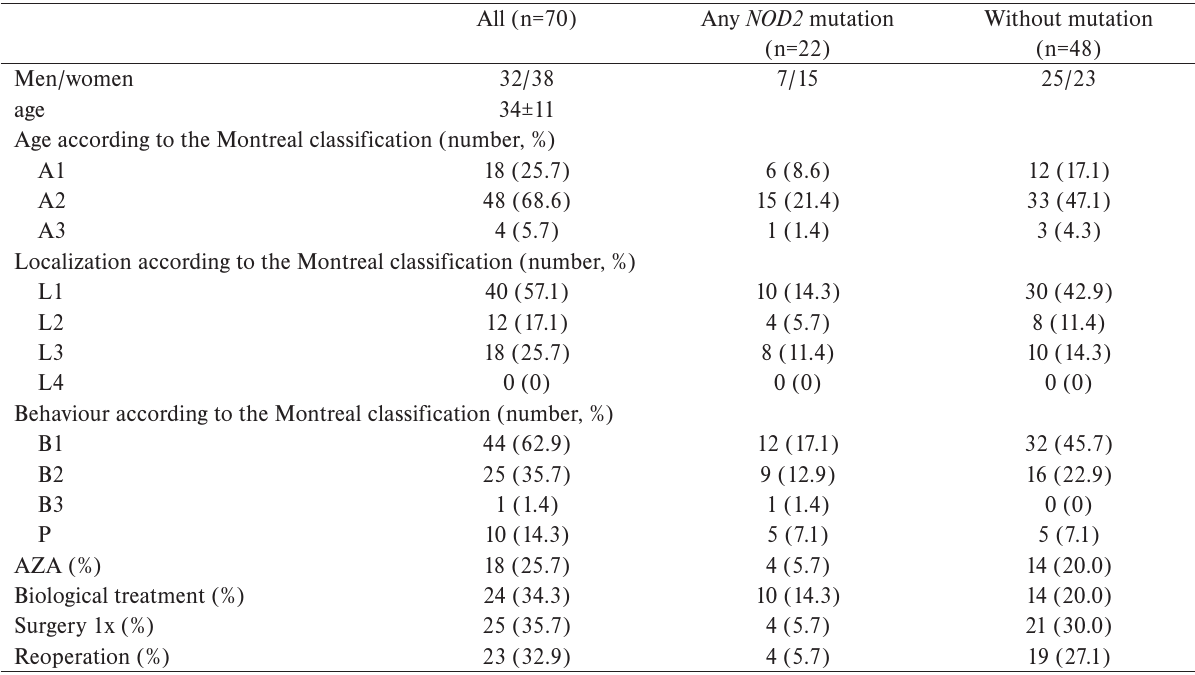
Table 1. Clinical characteristics of patients with Crohn’s disease generally and with respect to the presence of NOD2/CARD15